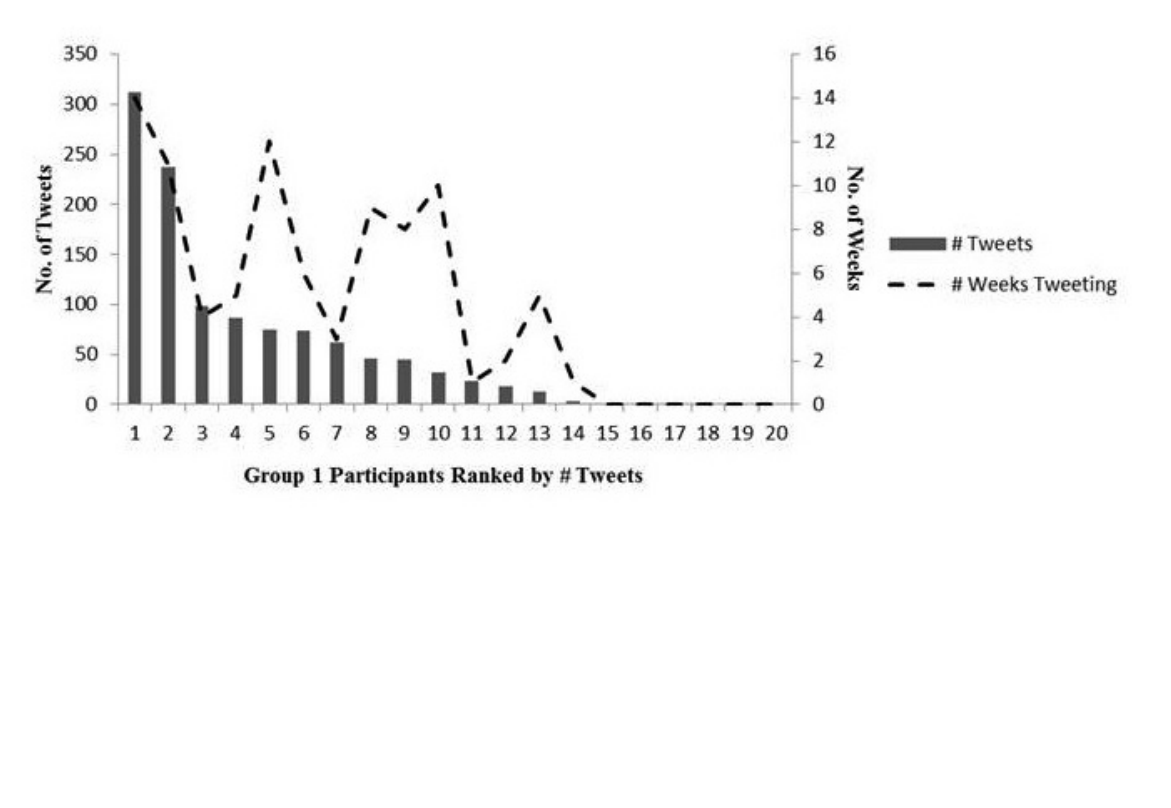
Figure 1. Tweeting volume and duration in Group